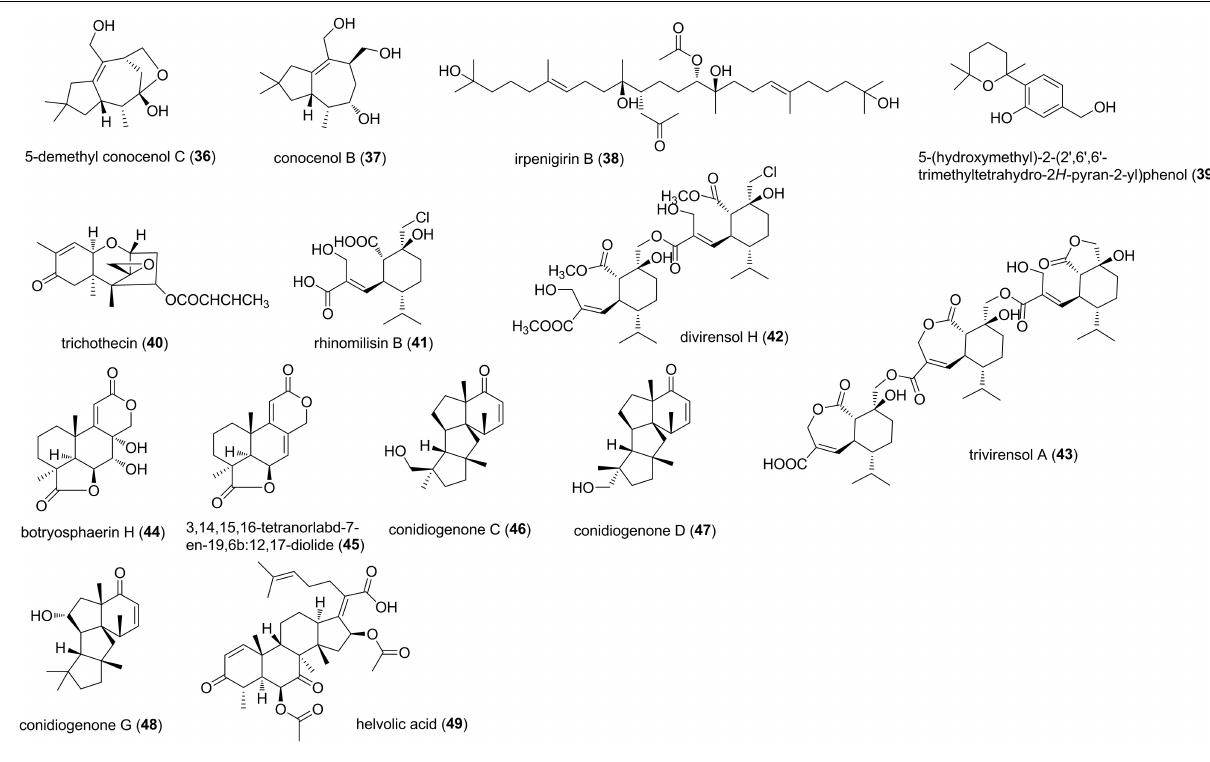
FIGURE 3 | Terpenoids characterized from endophytic fungi